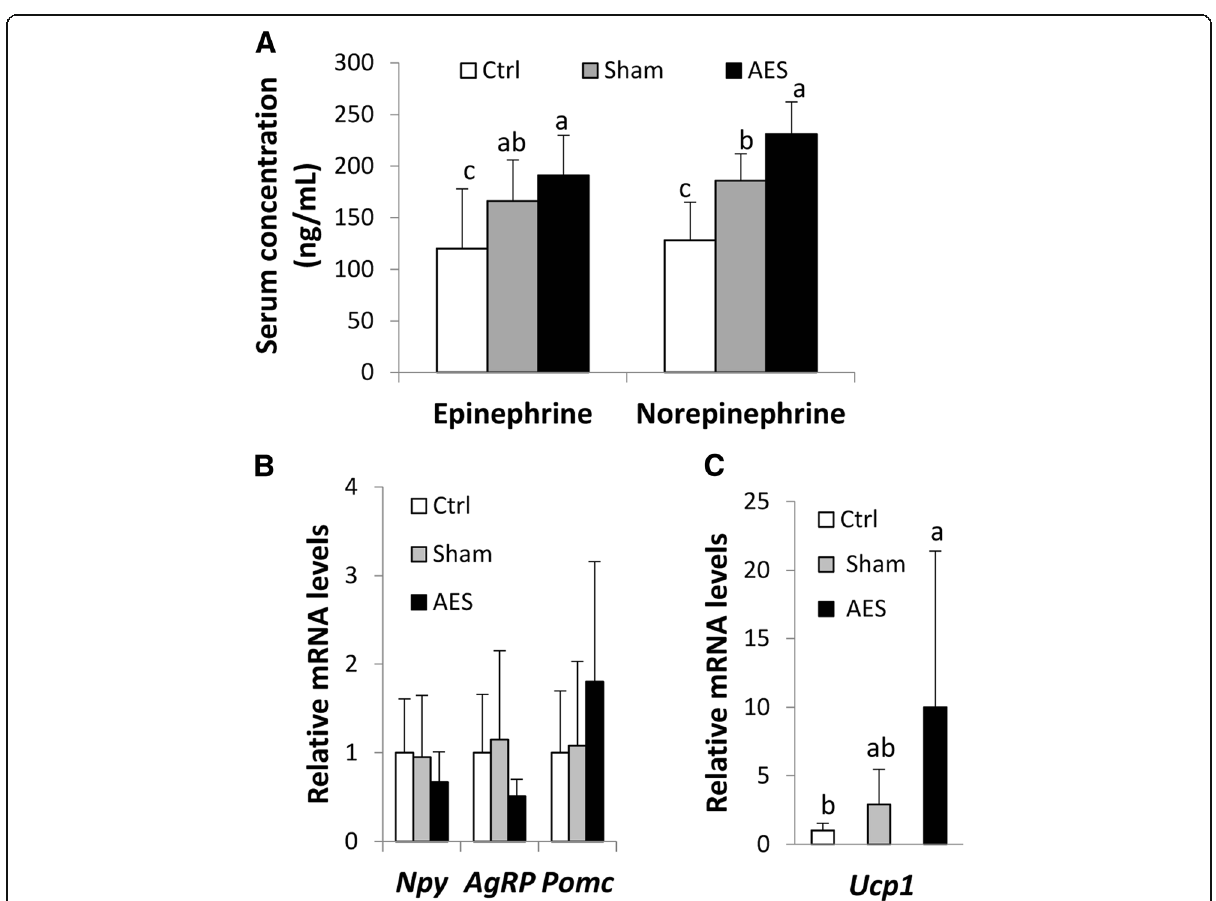
Fig. 2 Serum catecholamine concentrations ( a ) and mRNA levels of markers associated with appetite regulation in hypothalamus ( b ) and WAT browning in inguinal fat ( c ) of mice in three groups. Data are mean ± SD, n = 8. In ( b ) and ( c ), the comparison was based on the mRNA levels relative to Ctrl (taking as 1). a-c Means without a common letter differed ( P <